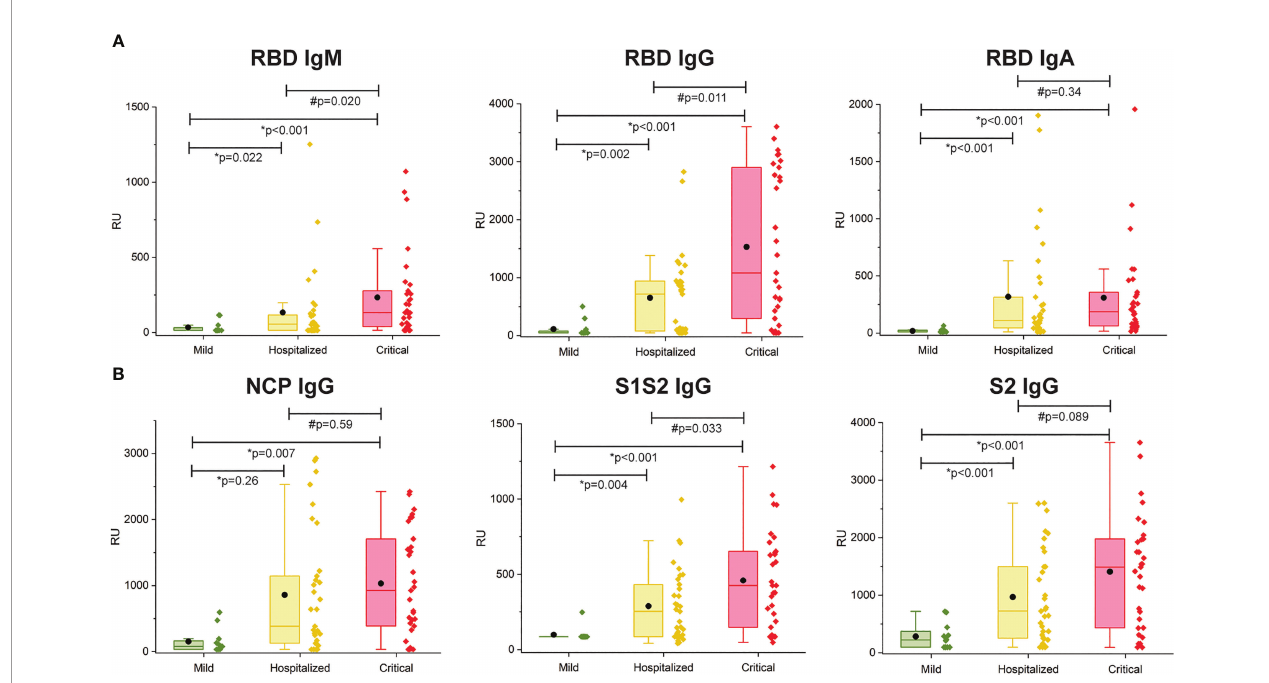
FIGURE 2 | Multiplex measurement of antibody responses to four antigens of SARS-CoV2. (A) Total immune response (IgM, IgG, IgA) SPRi measurement of COVID-19 – positive sera on RBD antigen. (B) IgG immune response SPRi measurement of NCP, S1S2, and S2 antigen. The boxplot represents the median, p25, and p75 values, and the black dot represents the mean SPRi RU value Comparability of groups was analyzed by Mann – Whitney U test. A Bonferroni – Holm procedure was used to correct for multiple comparisons between